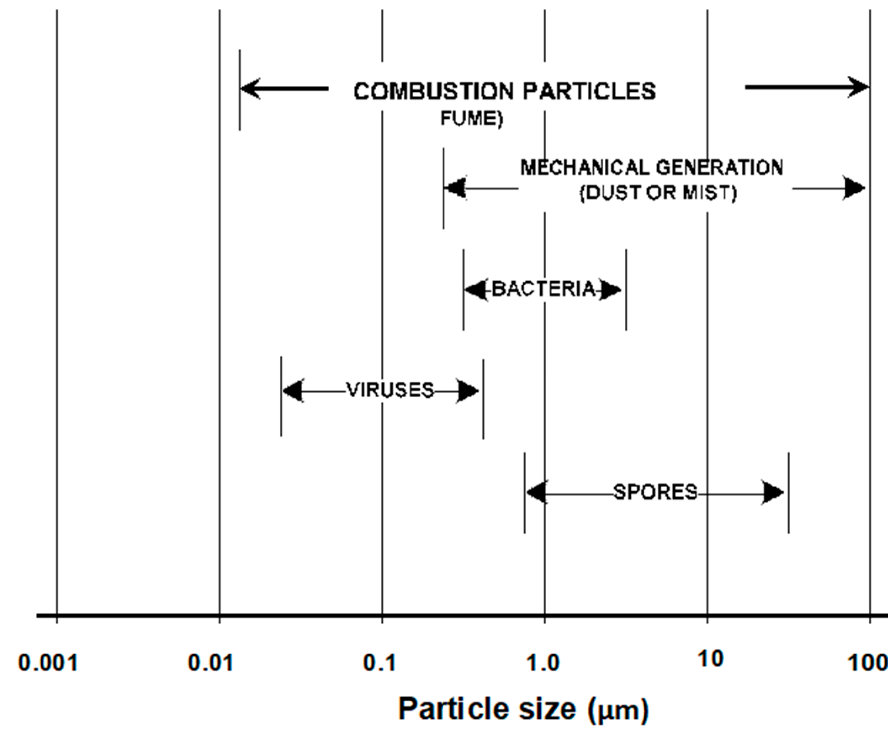
Figure 2. Range of small particle sizes.